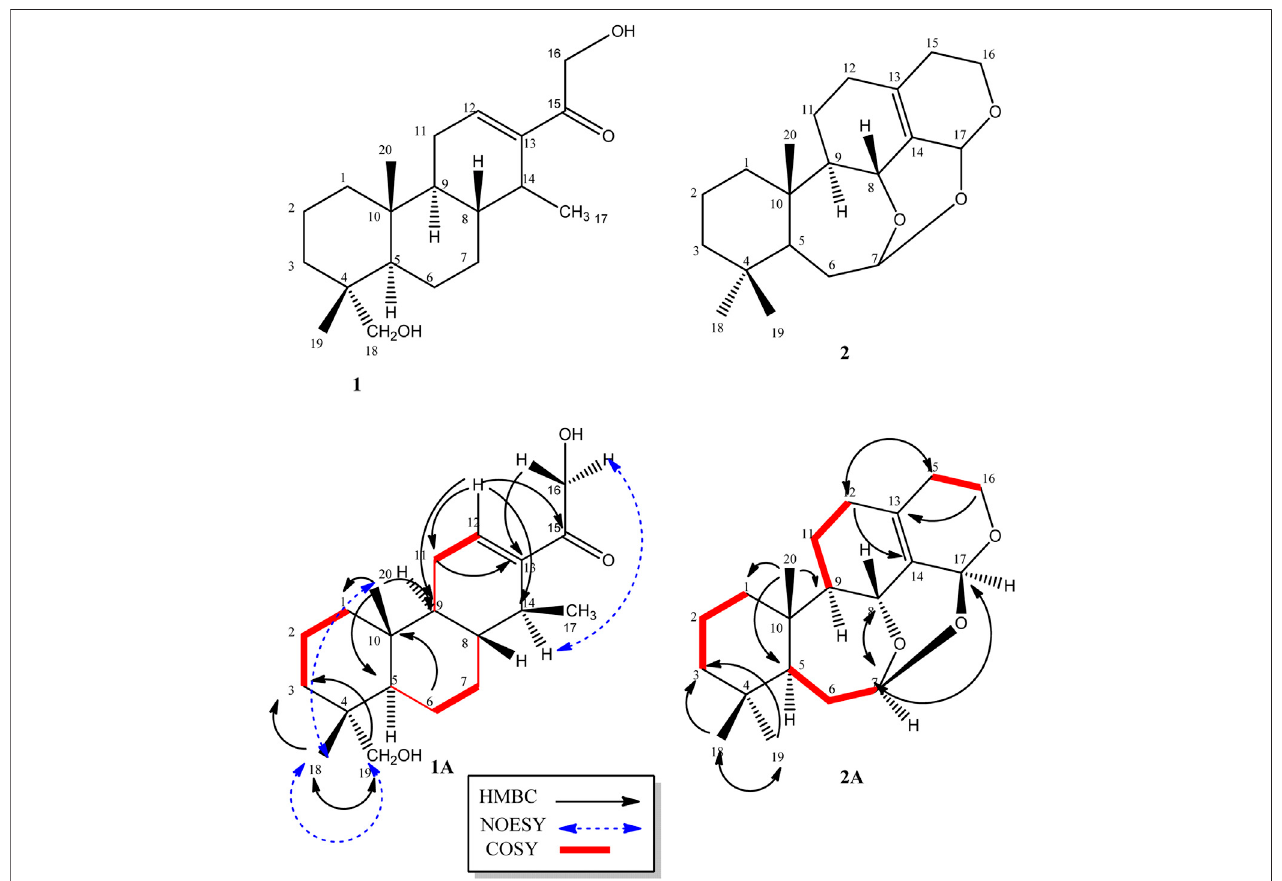
FIGURE 1 | Structure of compounds 1 and 2, including their selected COSY and HMBC correlations (1A and 1B).